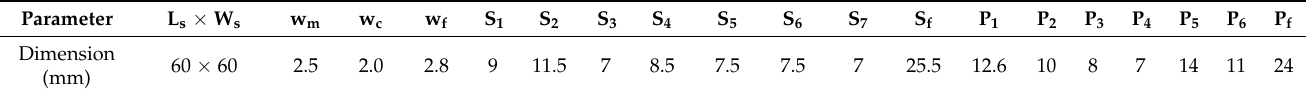
Table 1. Design parameters of single unit meander-line antenna.